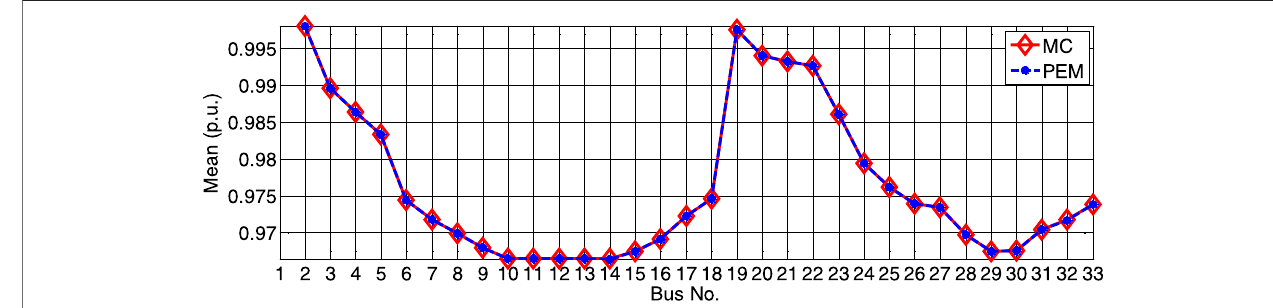
FIGURE 10 | Mean value of the elements from bus voltage pro fi les.